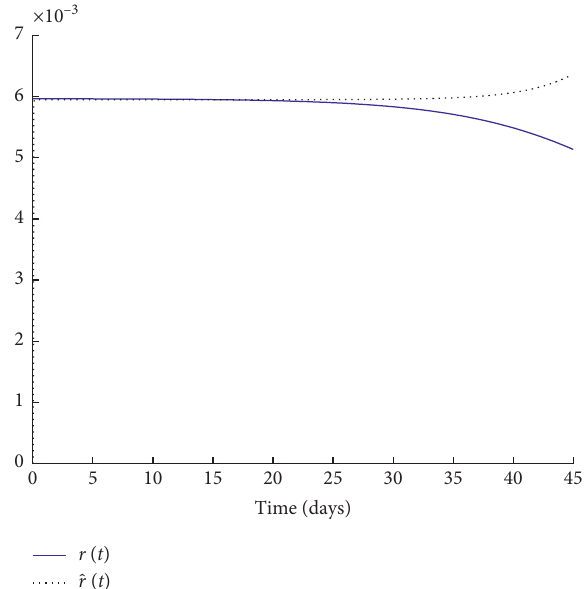
Figure 8: Estimation of the Malthusian parameter from the SIR